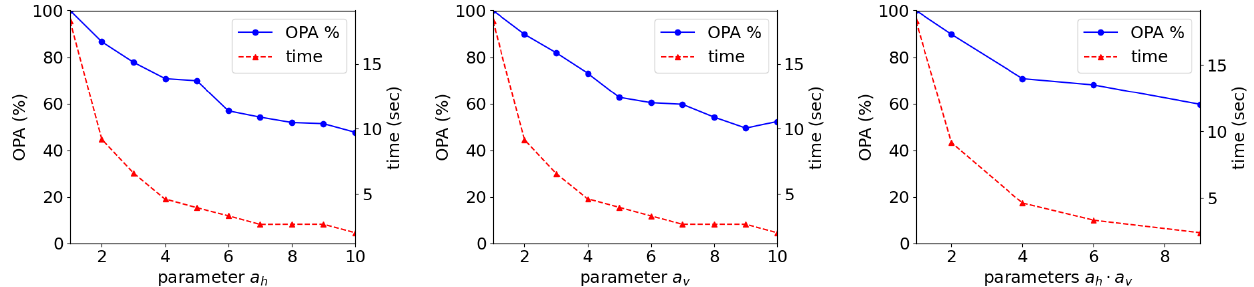
Figure 4. Experiment for parameters of AESOP